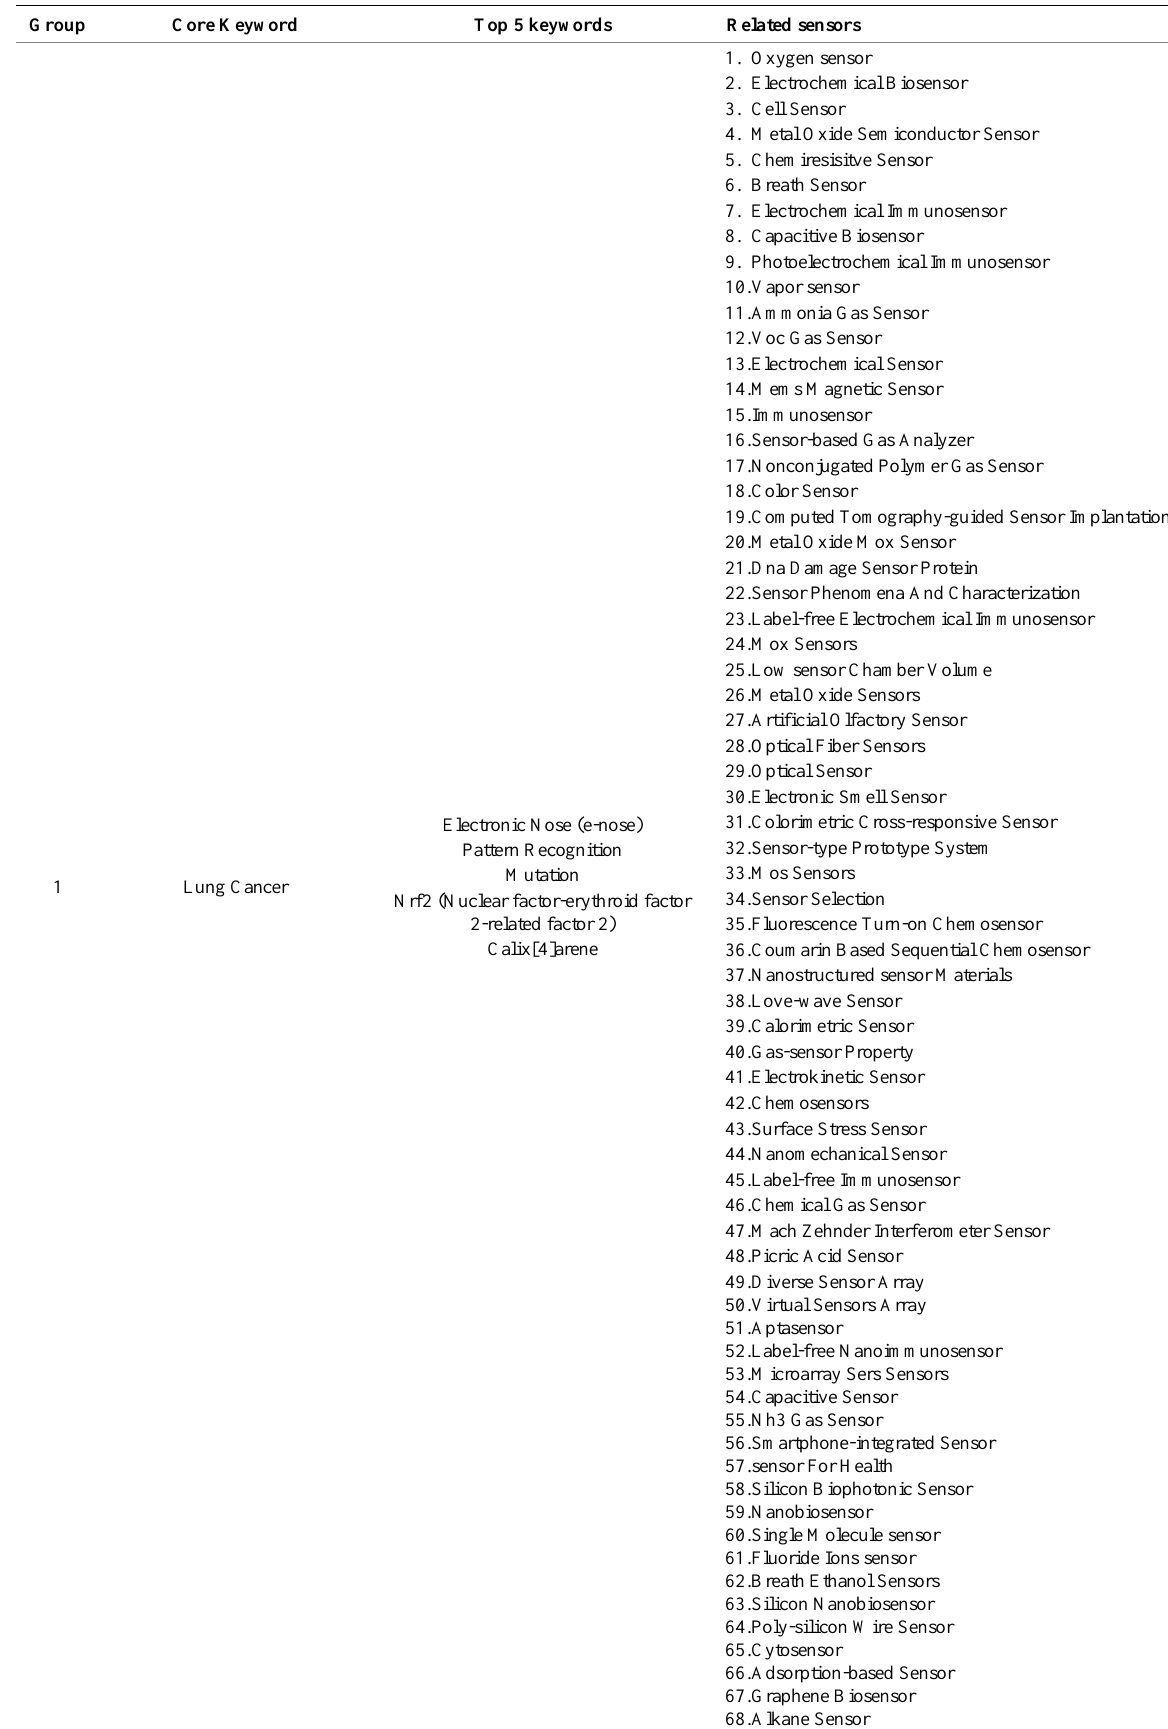
Table 2A. Groups, Core keywords and related sensors in the lung cancer network Group Core Keyword Top 5 keywords Related